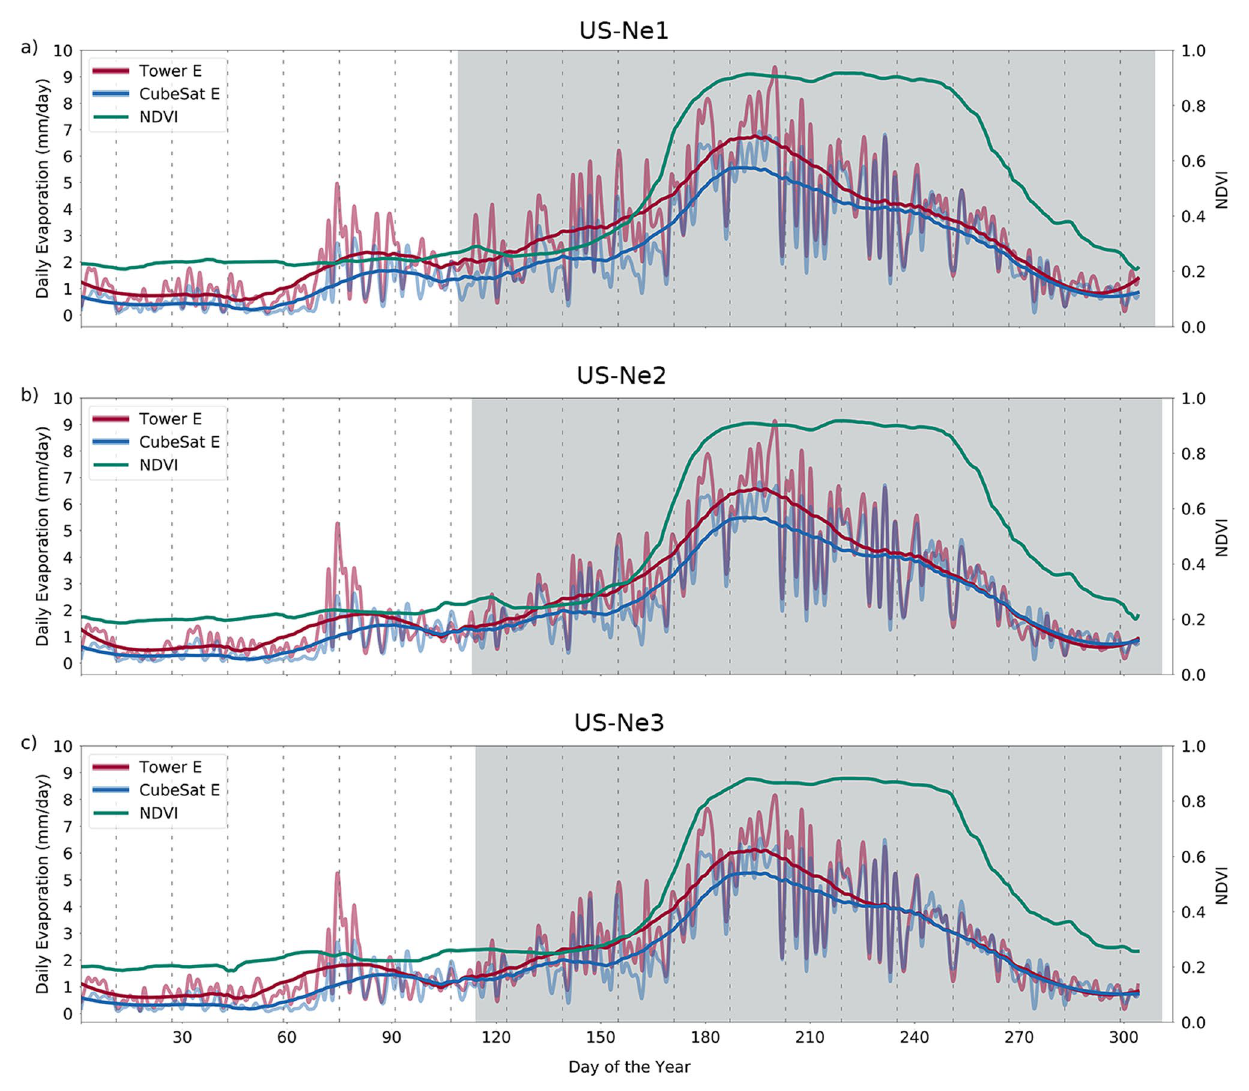
Figure 3. Time series of daily E for the CubeSat-based and closure-corrected EC measured fluxes, together with field-scale averaged NDVI for ( a ) US-Ne1, ( b ) US-Ne2, and ( c ) US-Ne3. The solid lines for the residual corrected and CubeSat E are smoothed versions of the original time-series. The shaded areas represent the length of the growing season (typically May–October), while the dashed lines represent the scheduled Landsat-8